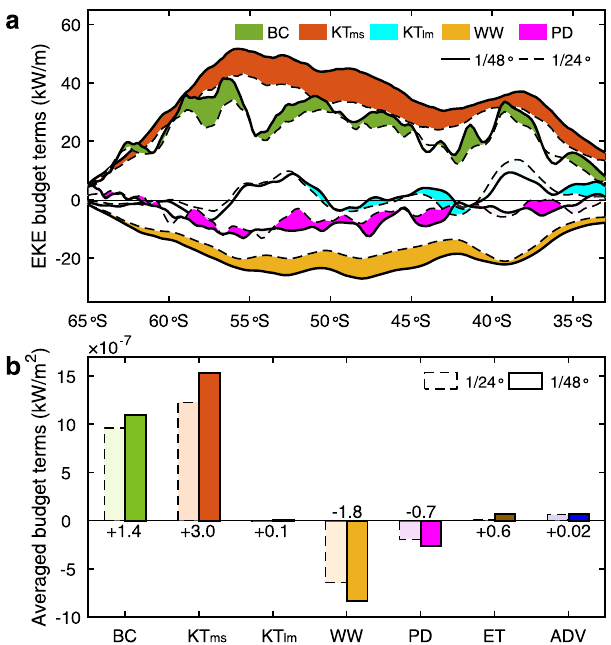
Fig. 4 | Mesoscale eddy kinetic energy budget of the Southern Ocean. a Latitudinal distributions of the zonally integrated mesoscale eddy kinetic energy (EKE me ) budget terms, including baroclinic conversion from available potential energy (BC), kinetic energy transfer between mesoscale and submesoscale eddies (KT ms ), kinetic energy transfer between mesoscale eddies and large-scale currents (KT lm ),windstresswork(WW),anddivergenceofpressurework(PD).Thedetailed de fi nitions ofthese budget terms can be found in Methods. Solid and dashedlines denote results from the 1/48° and 1/24° simulations, respectively. Differences between the solid and dashed lines are marked using fi ll colors with the dark and light ones denoting that the magnitudes are strengthened and weakened, respec- tively. b Spatially averaged EKE me budget terms in the Antarctic Circumpolar Currentband(i.e.,40 – 65°S).Resultsfromthe1/48°(1/24°)simulationaredenoted by dark(light)colorswith solid (dashed) edge lines. TheabbreviationsETand ADV denote EKE me tendency and advection of EKE me , respectively. Because of their small magnitudes, the ET and ADV are not plotted in a . Compared with the 1/24° simulation, the KT increased in the 1/48° simulation, its increase magnitude is much smaller than the